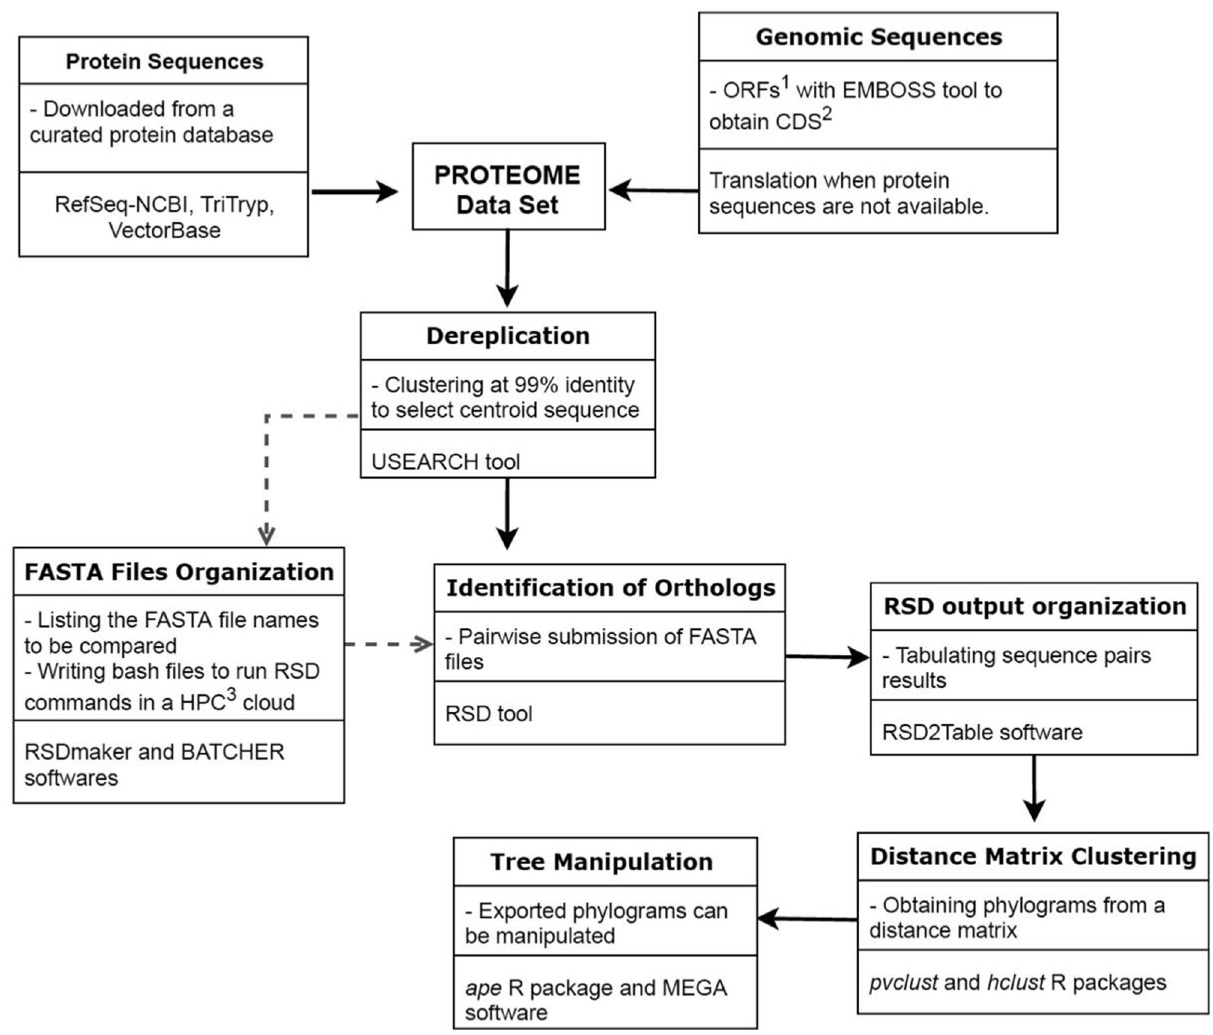
Figure 1. Workflow of TOMM approach for Phylogenomics. Main procedures are depicted, along with used software in each step. 1: open reading frame; 2: coding sequences; 3: High-Performance